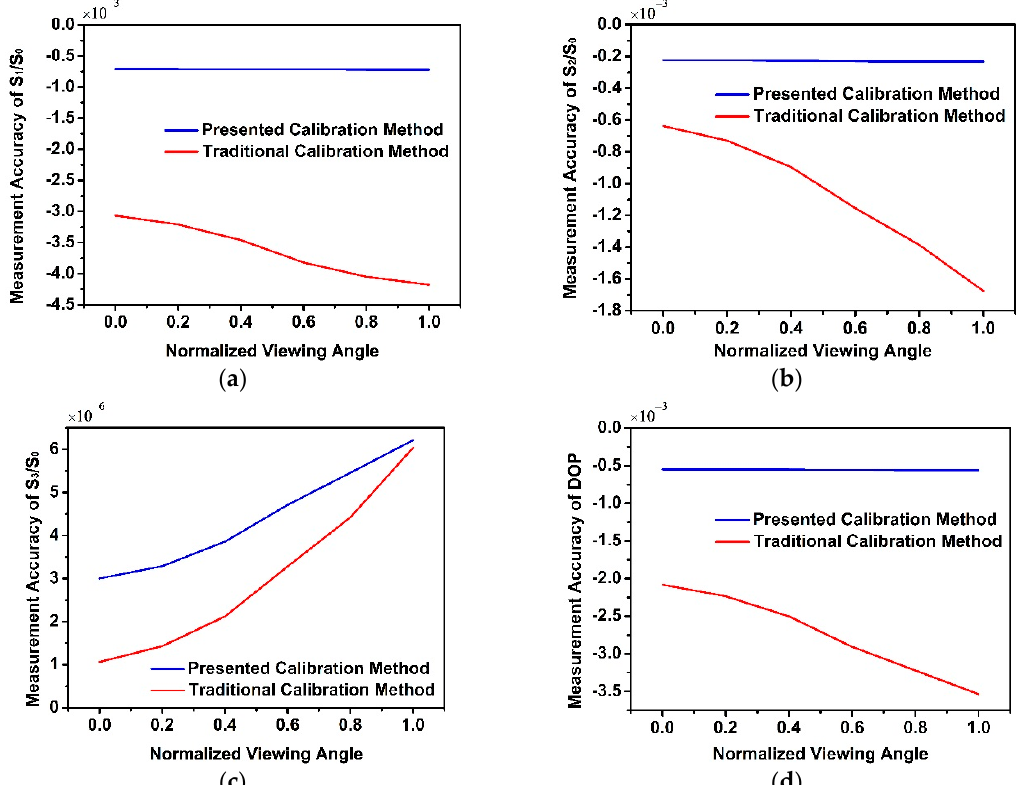
Figure 10. Measurement accuracy of normalized Stokes vectors and DOP, ( a ) S 1 / S 0 ; ( b ) S 2 / S 0 ; ( c ) S 3 / S 0 ; and ( d ) DOP. Wherein the blue and red lines respectively represent the presented calibration method and the traditional calibration method.